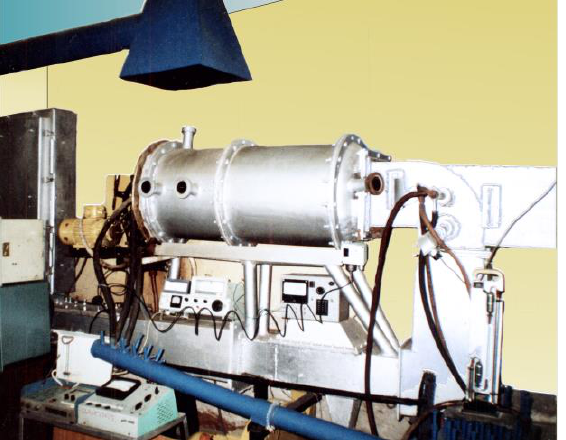
Figure 1. Experimental setup.